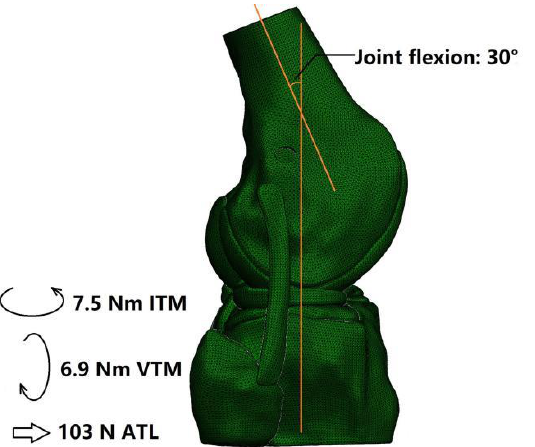
Figure 3. Boundary and loading conditions. ITM: internal tibial moment; VTM: valgus tibial moment; ATL: anterior tibial load.